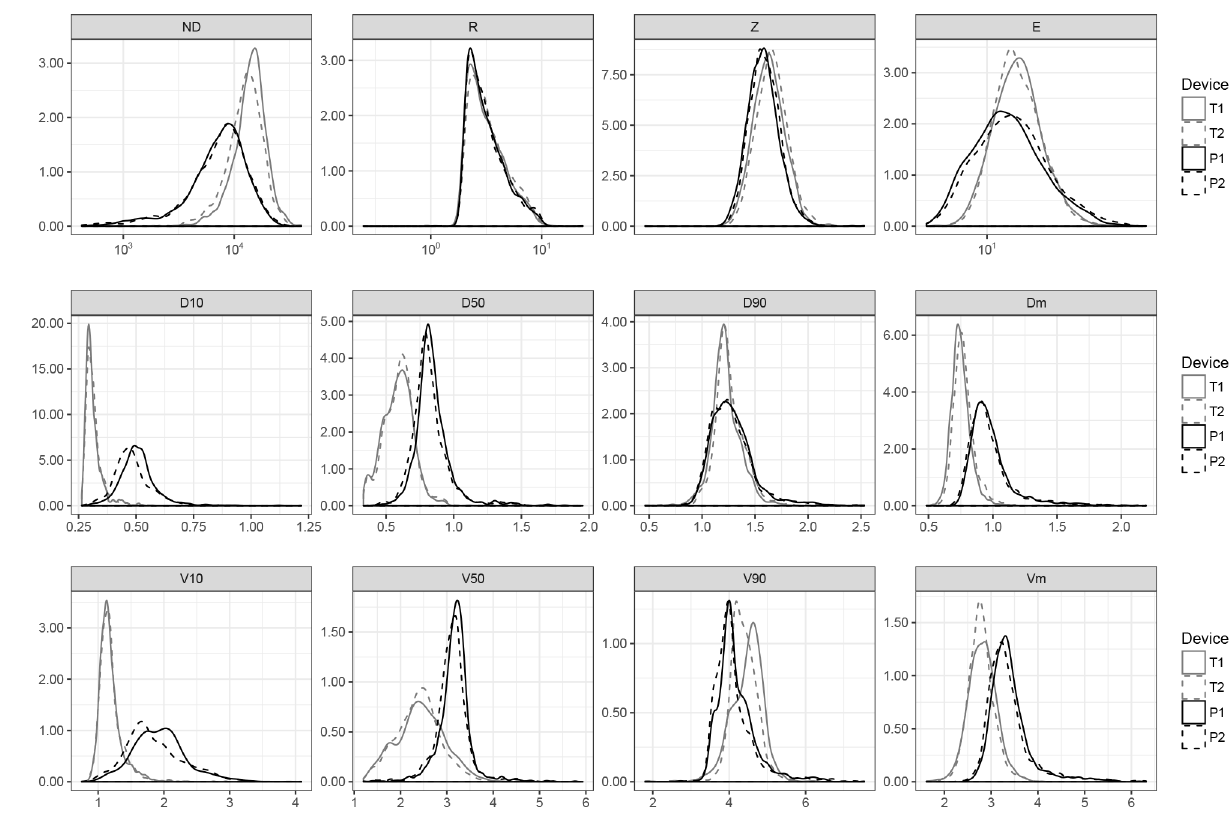
Figure A5. Kernel density plots for medium rainfall intensities (2 <I < 10mmh − 1